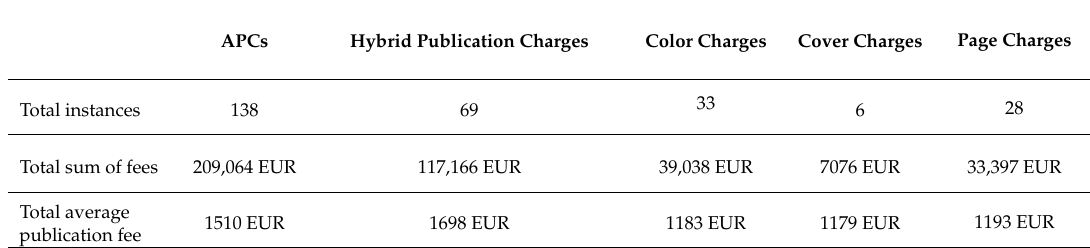
Table 3. Total instances and total sum of publication